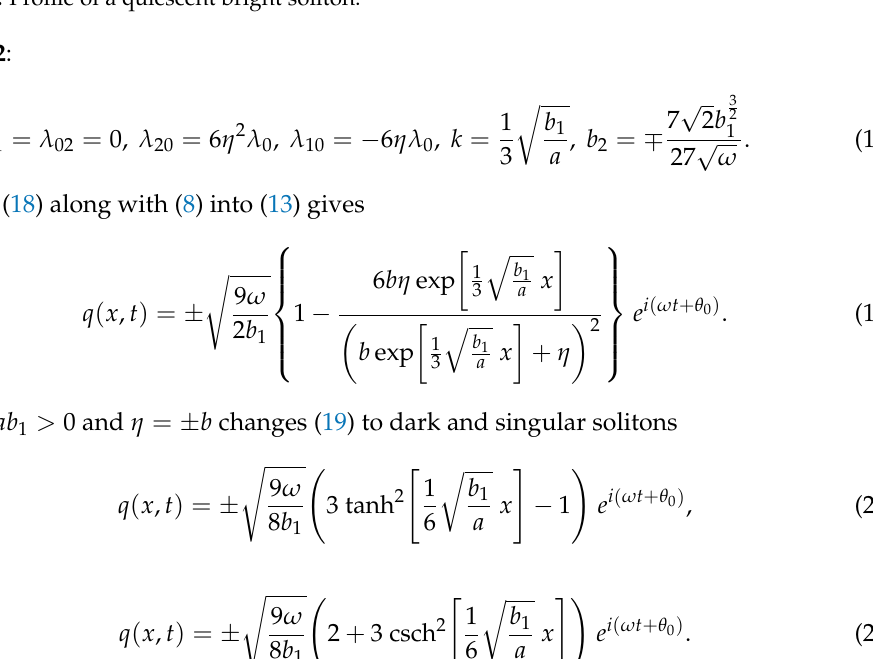
Figure 1. Profile of a quiescent bright